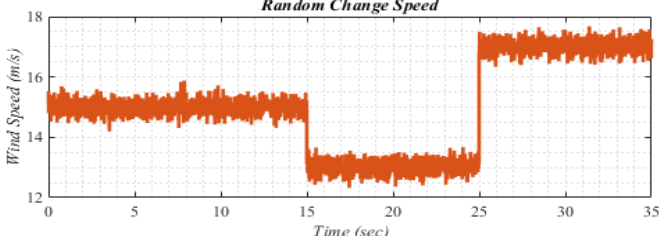
Figure 13. Profile of the random change of wind speed.